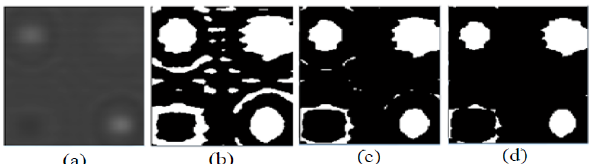
Figure 15. Images of the sample, showing the total process of target segmentation, using fuzzy c-mean clustering, followed by multi-thresholding and erosion, ( a ) original image, ( b ) fuzzy c-mean clustering, ( c ) erosion by structuring element object 10, and ( d ) erosion by structuring element object 15.